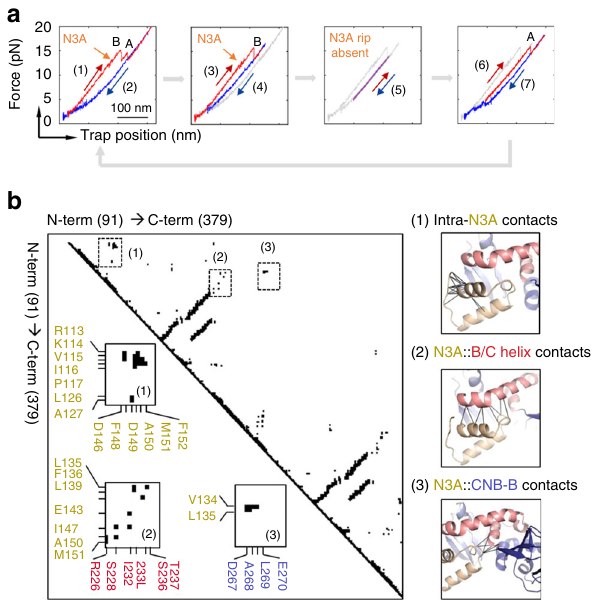
Fig. 4 The CNB-B domain bound to cAMP is required for the N3A motif to fold. a (1) The regulatory subunit unfolds (red) and (2) refolds (blue), revealing the fi rst reversible transition corresponding to the N3A motif (orange arrow). (3) In the following cycle, the regulatory subunit was stretched until the N3A motif and the CNB-B domain unfold, whereas the CNB-A domain remains folded. (4) The force was decreased to 4 pN, a force that does not allow the CNB-B domain to refold. (5) The force was then oscillated between 6 and 15 pN for several cycles (~20) to test whether the N3A motif was able to refold, while the CNB-B domains remain unfolded. (6) The force was increased to 20 pN to unfold the CNB-A domain. (7) The force was decreased to 1 pN, allowing the complete protein to refold and begin another set of experiments. The trajectories in gray represent the unfolding pathways from the immediately previous cycle, thereby serving as reference on the progression of experiment. b Pairwise contact map comparing the interaction established by the N3A motif in the regulatory subunit of PKA (left). The contacts established by the N3A motif were obtained using a 8 Å cutoff (right): (1) contacts established by residues within the N3A motif; (2) contacts between the N3A motif and the B/C helix; and (3) contacts between the N3A motif and the CNB-B domain. Cartoons rendering the three sets of contacts are shown next to the contact map. Residues in the N3A motif are colored in yellow, in the B/C helix in red, and in the CNB-B domain in